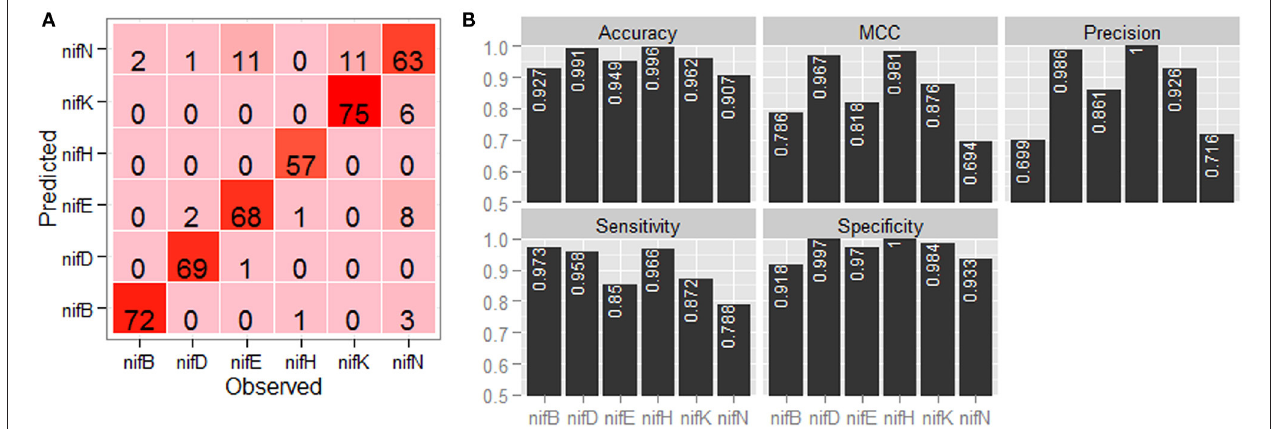
FIGURE 4 | Graphical representation of the prediction accuracy of the developed approach under jackknife validation. (A) Confusion matrix and (B) bar plots of performance metrics for classification of six categories of nitrogen fixation-proteins using jackknife validation technique. From the confusion matrix (color from light to dark represents lower to higher numbers), it is seen that the protein sequences are mostly misclassified in nifN category, whereas no sequence is misclassified in nifH category. From the performance metrics, accuracies in discriminating nifH , nifD, and nifK from rest of the sequences are found higher among the six categories of protein sequences.